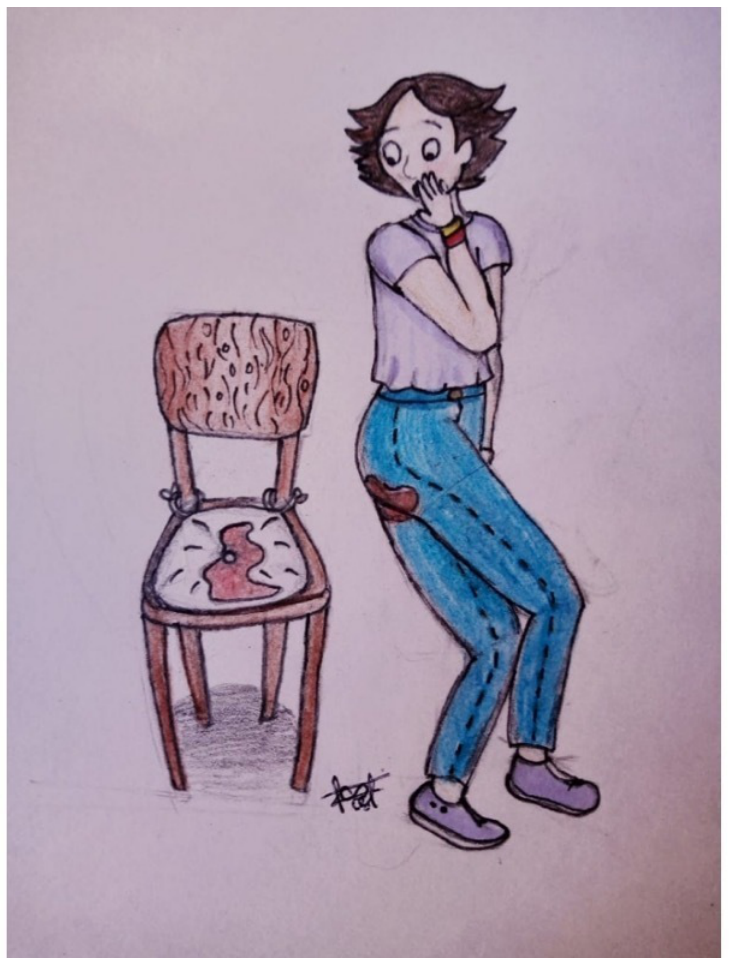
Figure 2 – Author: Celeste